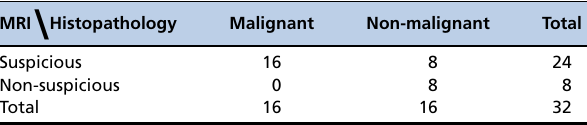
Table 4 - Comparison between magnetic resonance imaging (MRI) and histopathology of suspicious breast lumps in at least one of the methods